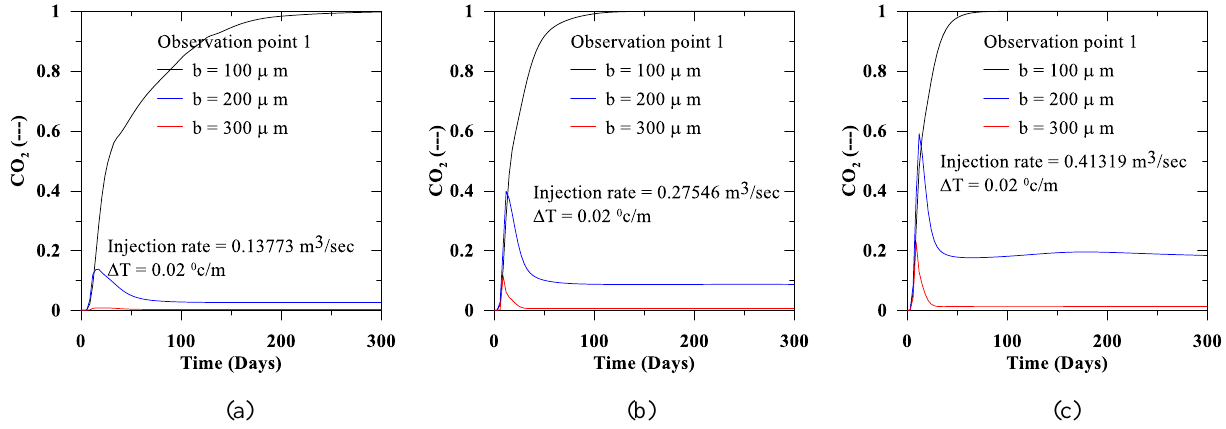
Figure 14. The CO 2 saturation at observation point 1 ( a – c ).